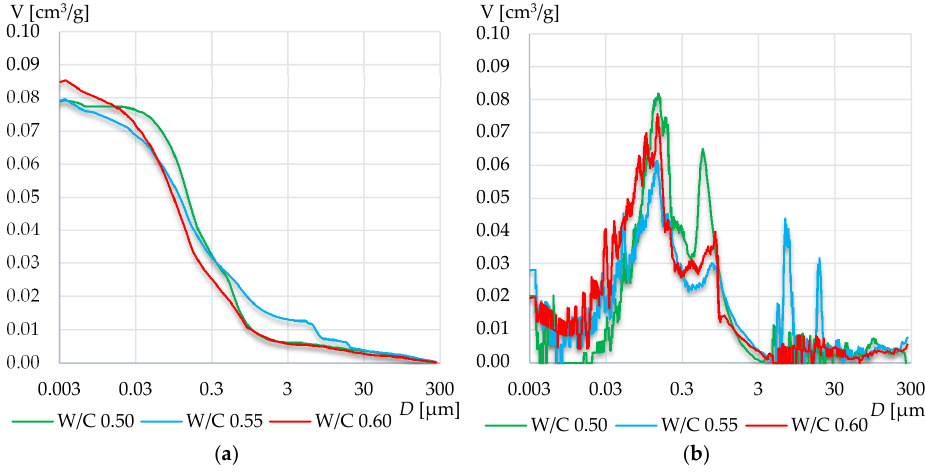
Figure 10. Cumulative distribution volume ( a ) and log ‐ differential pore distribution ( b ) graphs of the mortars based on CEM II A ‐ S 52.5N.